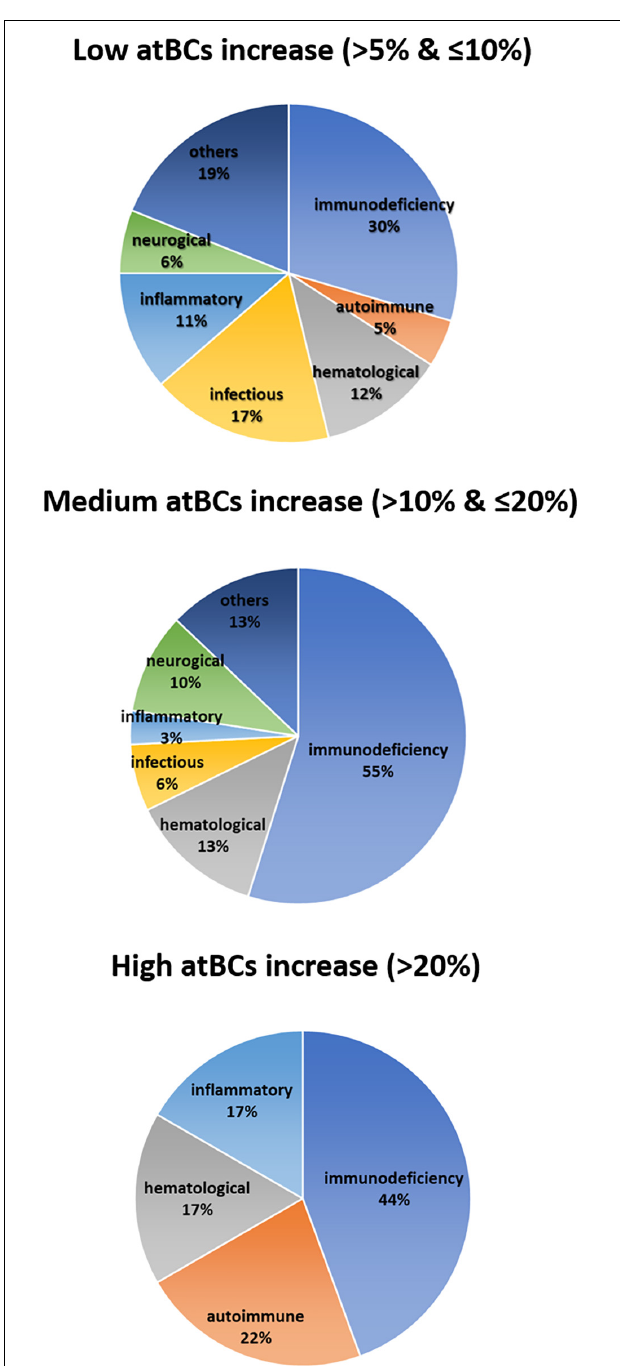
FIGURE 3 | Correlation between atBCs frequencies and pediatric disorders. Pie charts showing the frequency of observed pediatric diseases within the three groups of atBCs increase (low, medium, and